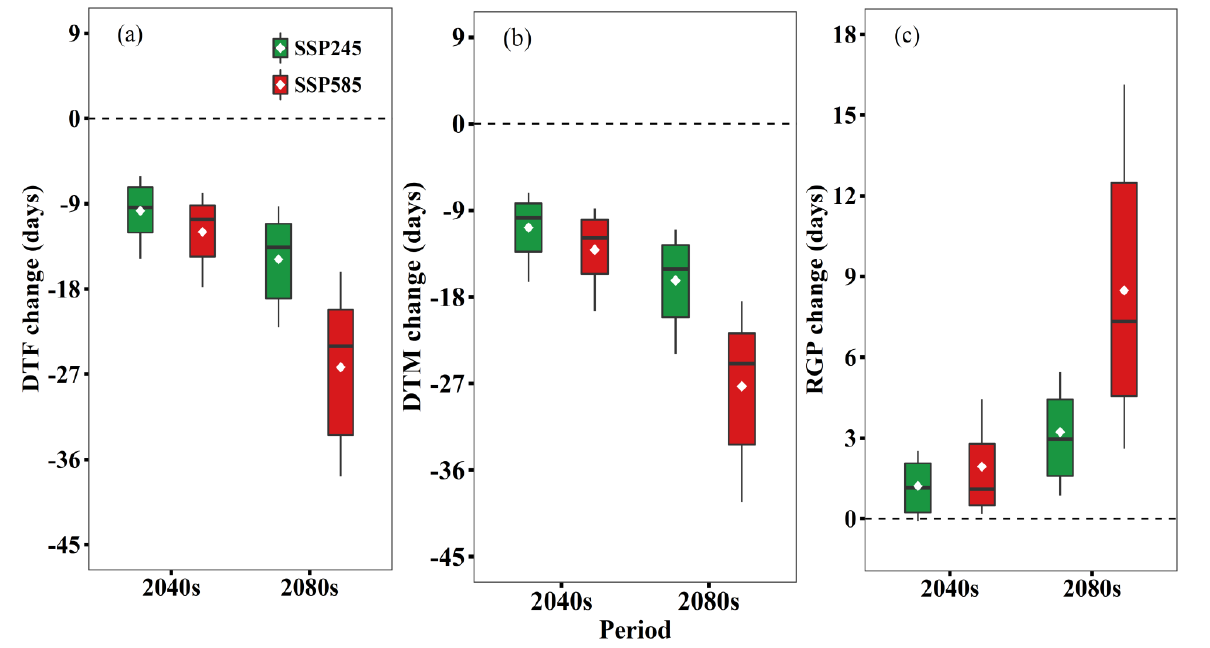
Figure 3. Projected changes in days to flowering (DTF) ( a ), days to maturity (DTM) ( b ), and repro- duction growth period (RGP) ( c ) in 2030−2059 (2040s) and 2070−2099 (2080s) relative to the baseline (1961−2000) under SSP245 and SSP585 based on 21 GCMs. Box boundaries indicate the 25th and 75th percentiles across GCMs, and whiskers below and above the box denote the 10th and 90th percentiles. The black lines and dots inside the box indicate the multi-model median and mean, respectively.